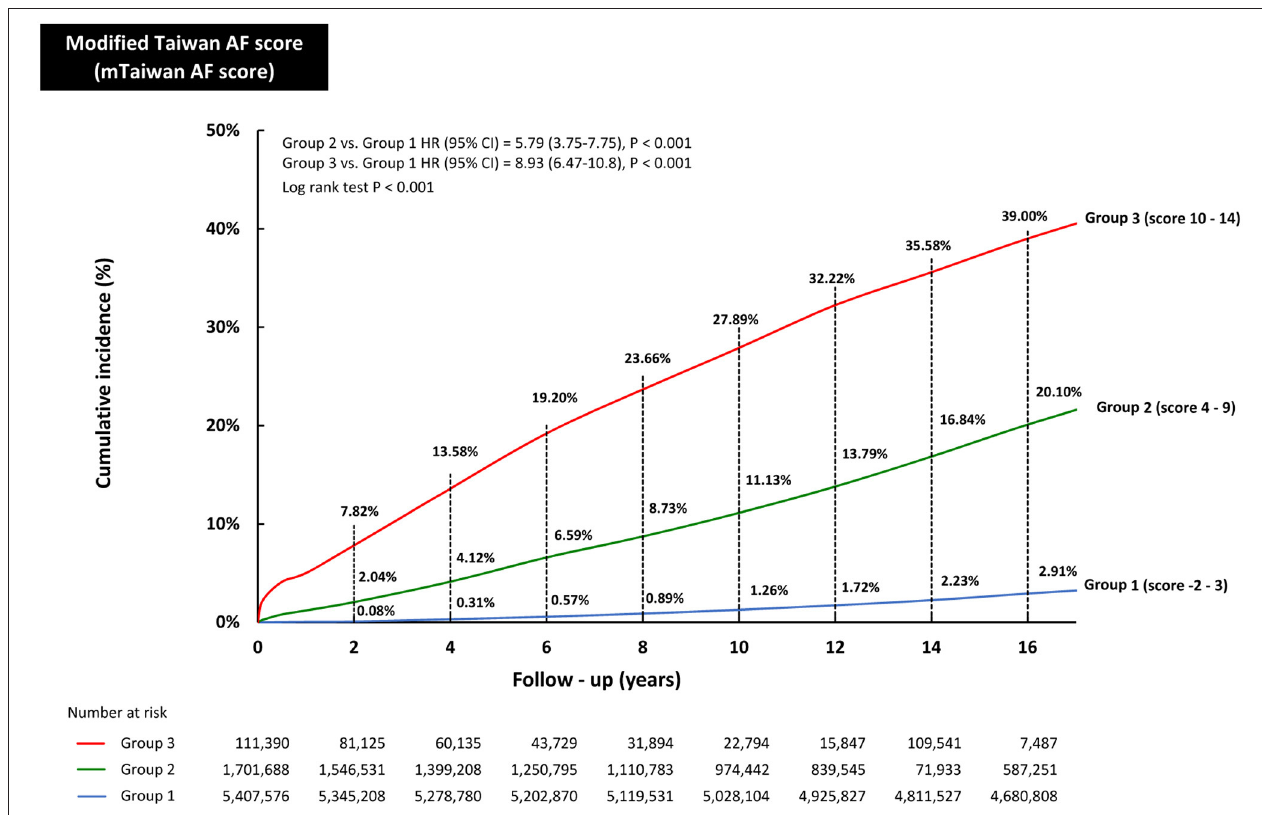
FIGURE 3 | The cumulative incidence curves of developing AF in groups 1, 2, and 3. The 2-year risks of AF were 0.08, 2.04, and 7.82% for groups 1, 2, 3, respectively. The 6-year risks of AF were 0.57, 6.59, and 19.20% for groups 1, 2, 3, respectively. The 10-year risks of AF were 1.26, 11.13, and 27.89% for groups 1, 2, 3, respectively. The 16-year risks of AF were 2.91, 20.10, and 39.00% for groups 1, 2, 3, respectively. Compared to group 1, the HRs of incident AF were 5.79 (95% CI 3.75-7.75) for group 2 and 8.93 (95% CI 6.47-10.80) for group 3. AF, atrial fibrillation; CI, confidence interval; HR, hazard